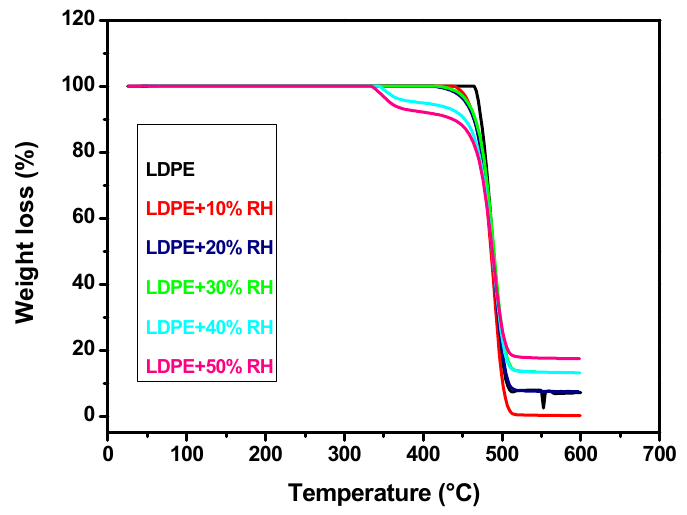
Figure 9. TG curves of the neat LDPE and LDPE/RH biocomposites containing different RH content at a heating rate of 10 ◦ C min –1